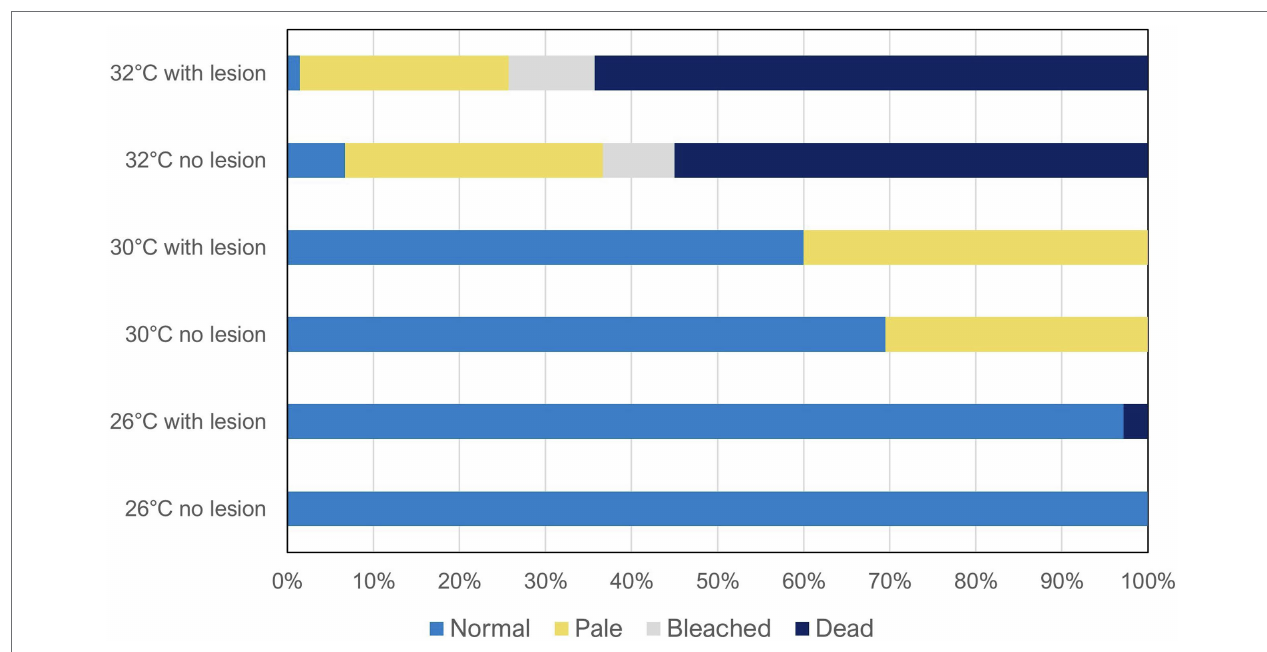
FIGURE 1 | Coral reef health condition (normal, pale, bleached, and dead) after 60 days of exposure to the different treatments (temperatures: 26 vs. 30 vs. 32 ° C; predation: no lesion vs. with wound lesion). The graph shows average percentage values for all species combined ( N = 60 fragments per species, N total = 420 coral